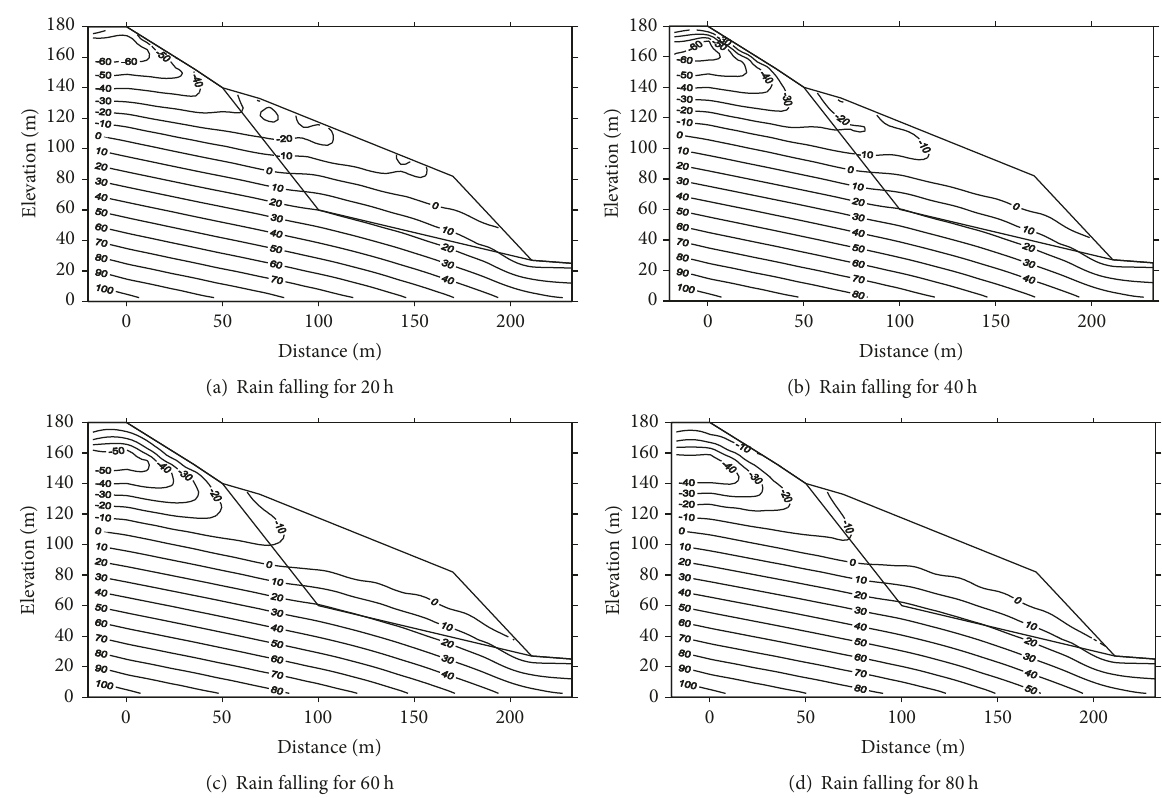
Figure 8: Pressure head contours of rainfall intensity 8 mm/h.